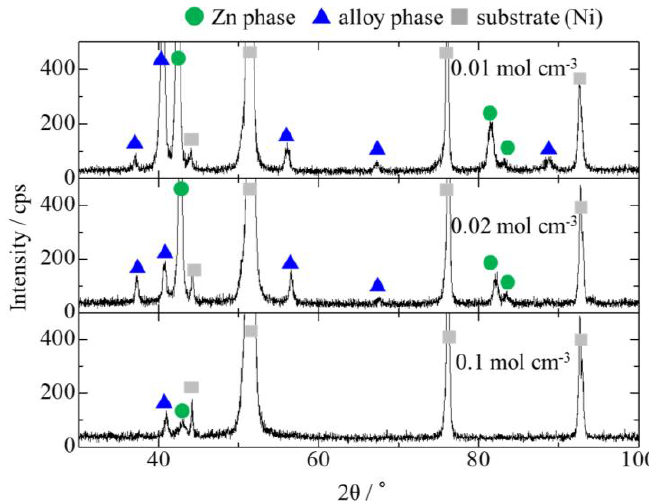
Figure 16. XRD patterns of the Zn–Fe–Mo plating deposited from a plating bath with different Mo concentrations.